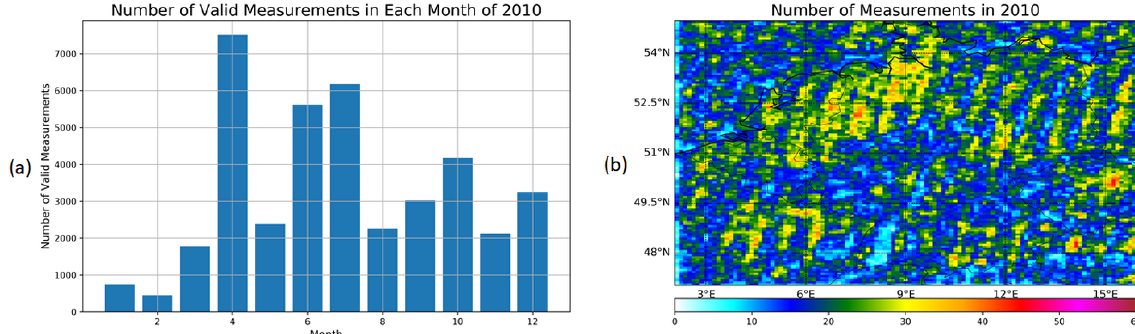
Figure J1. The bar plot of the number of IASI measurements as a function of measuring month (a) . The spatial distribution of the number of valid IASI measurements (b)